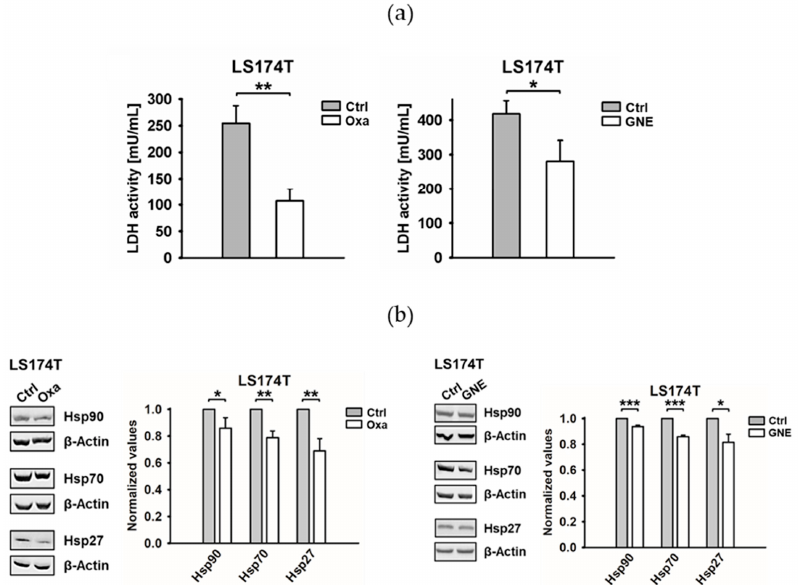
Figure 1. Lactate dehydrogenase (LDH) inhibition by oxamate (Oxa) and GNE-140 (GNE) decreases the expression of Hsp90, Hsp70 and Hsp27. ( a ) The effect of Oxa (60 mM, 48 h) and GNE (10 µM, 24 h) on LDH activity in LS174T cells (*: p ≤ 0.05 and **: p ≤ 0.01). ( b ) Representative immunoblot showing the intracellular expression of Hsp90, Hsp70 and Hsp27 in untreated (Ctrl) and Oxa- or GNE-treated LS174T cells. β -Actin was used as a loading control. The quantification of the heat shock protein (HSP) expression levels is shown in the adjacent bar chart. Error bars show the standard deviations (SD) of at least three biological replicates (*: p ≤ 0.05, **: p ≤ 0.01 and ***: p ≤ 0.001). Full Western blot images are available in Figure S4. Cancers 2021 , 13 , x